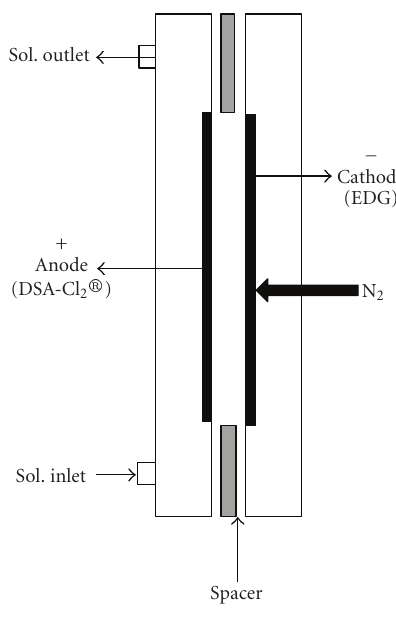
Figure 1: Representative scheme of the electrochemical reactor used in this